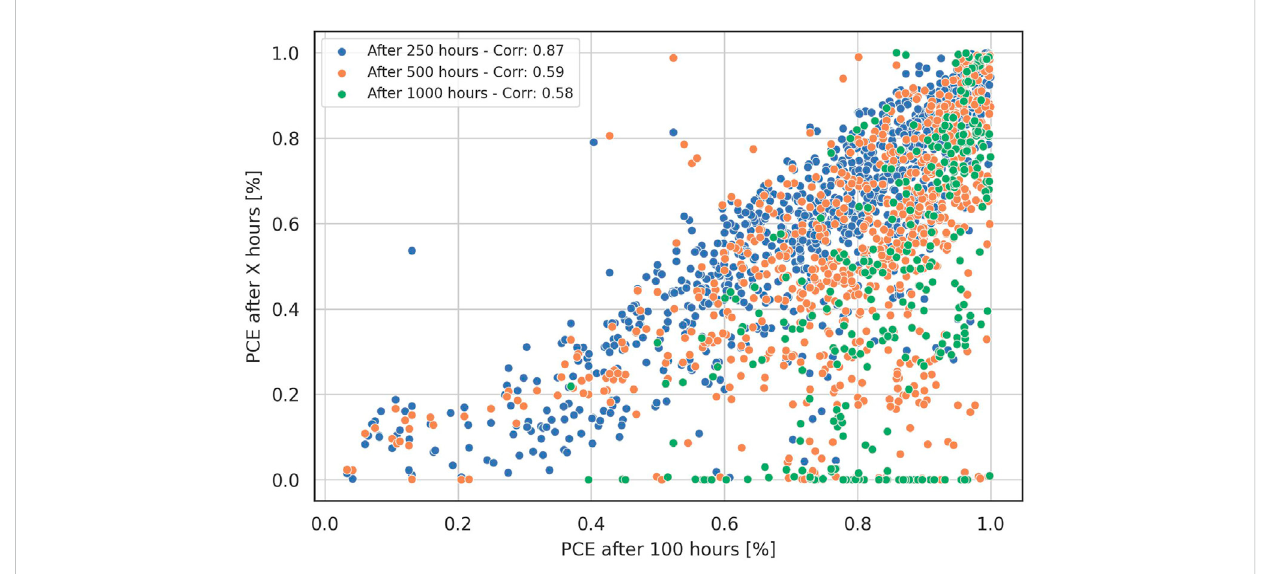
FIGURE 12 Scatter plot and correlation of the PCE normalized with the PCE at time 0, after 100 h, and the PCE at 250, 500, and 1,000